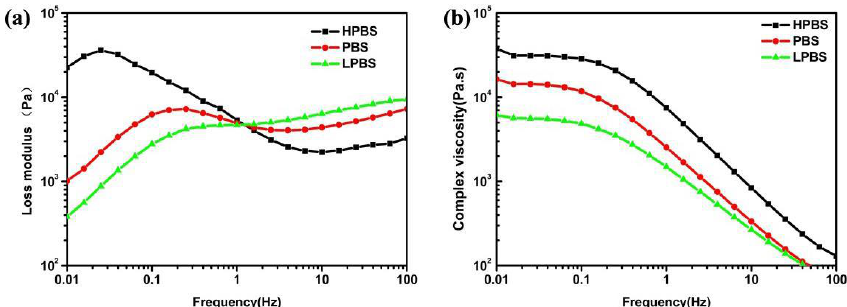
Figure 2. With the increase of shear frequency the loss modulus and complex viscosity of PBS gels with different molecular weights show the same trend. However, there is a significant difference in their loss modulus values. In addition, the loss modulus and complex visicosity of gel increase with the increase of molecular weight.